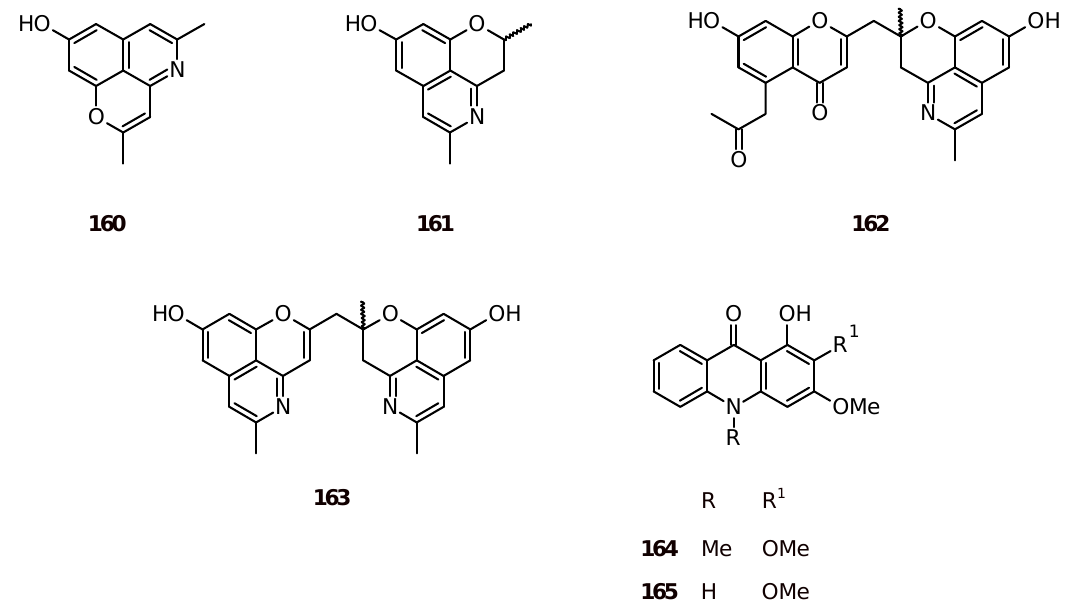
Figure 18. Structures of alkaloids 160 - 165